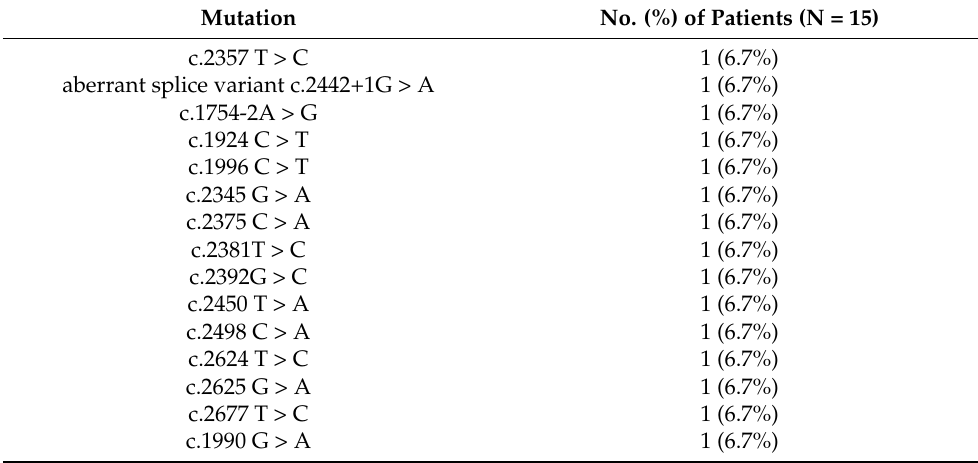
Table 1. List of CSF1R mutations of the 15 patients included into the